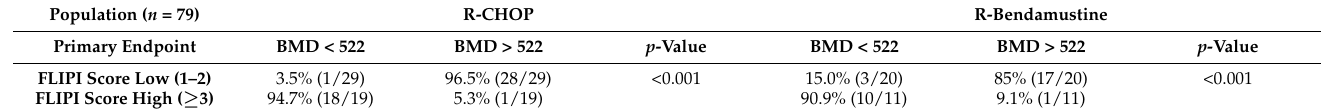
Table 5. Comparison of FLIPI Score and BMD cut-off results of R-CHOP-like vs. R-B therapy.